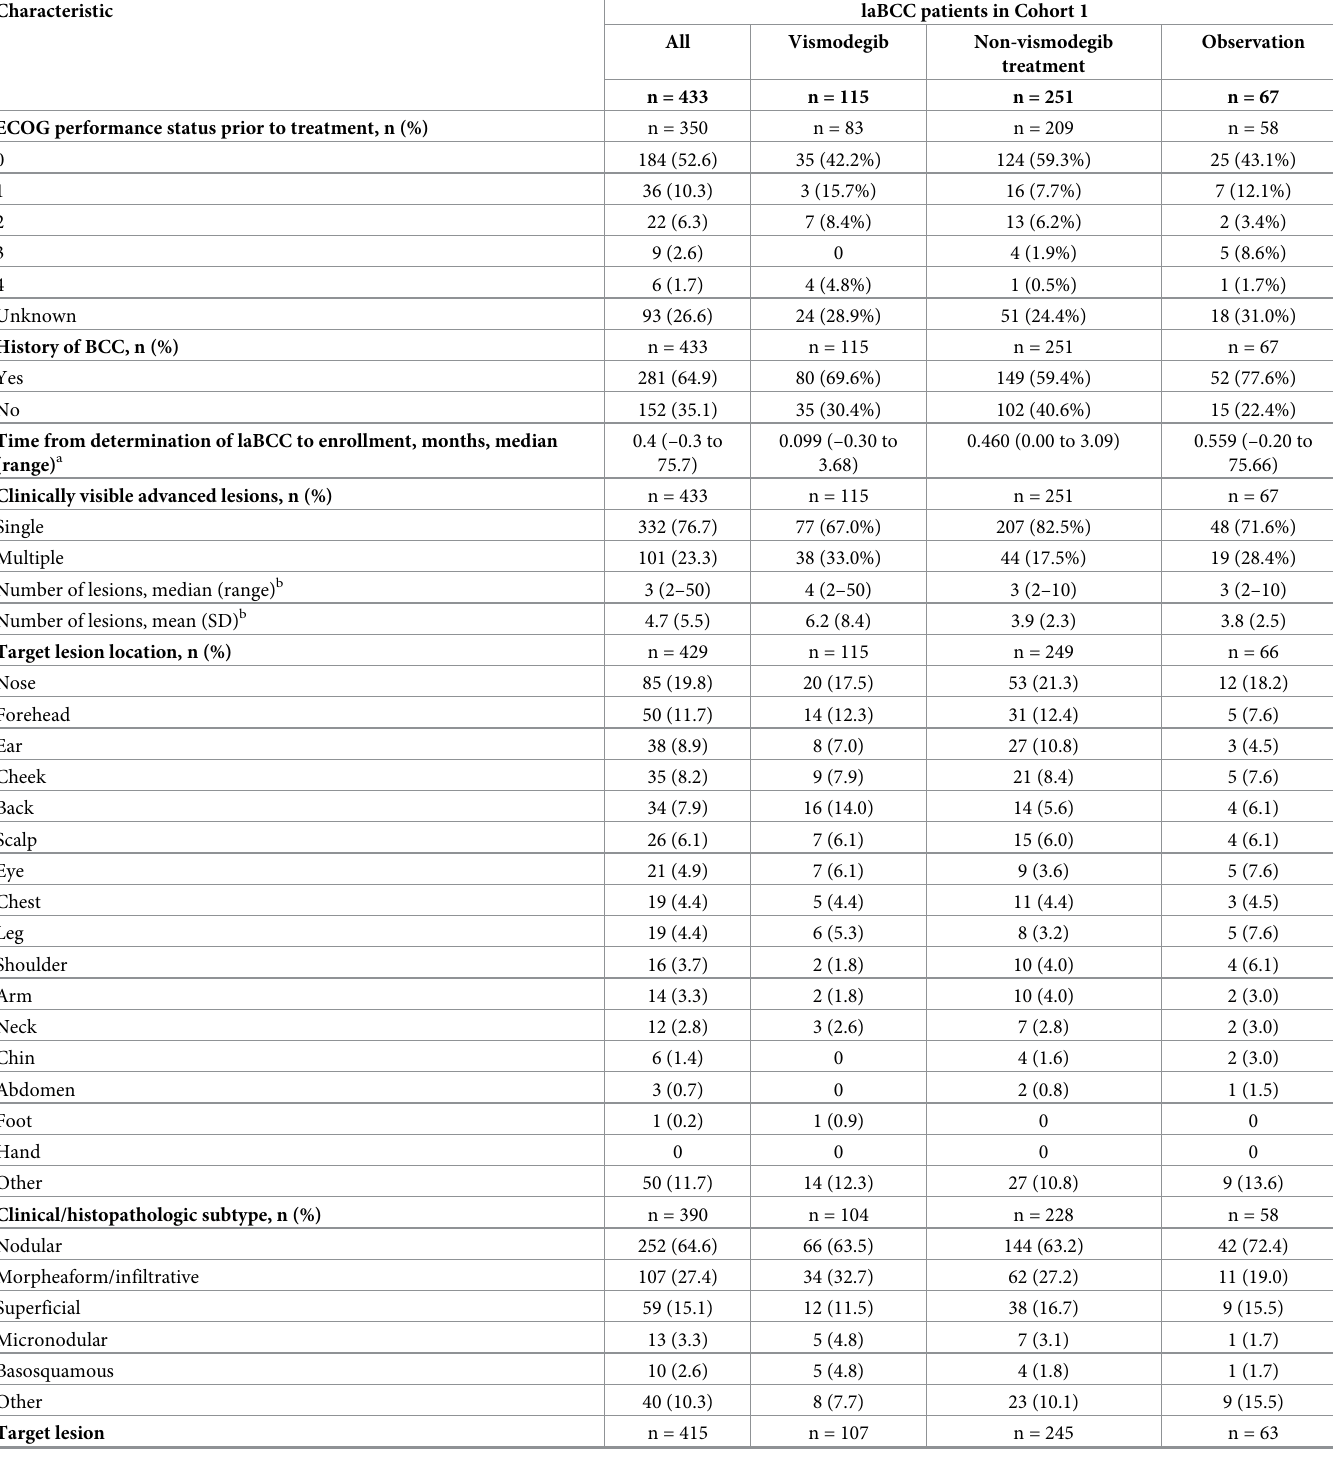
Table 3. Baseline disease characteristics in patients with locally advanced basal cell carcinoma in Cohort 1.